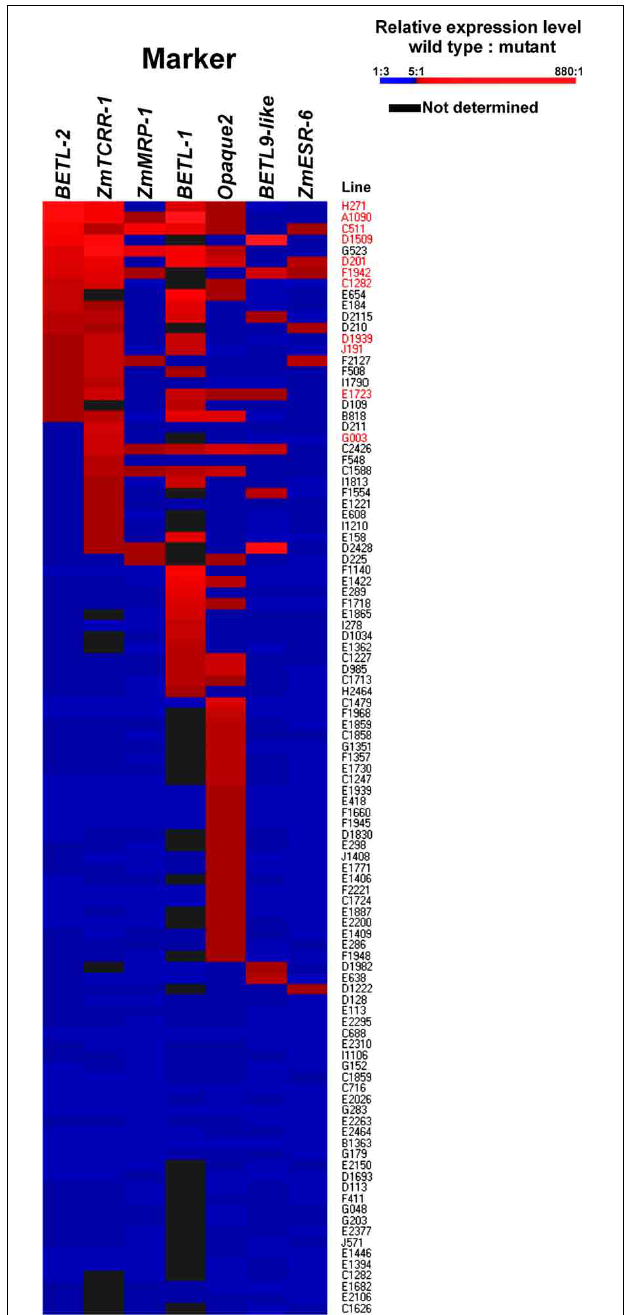
FIGURE 4 | Organization of the 101 lines according to marker expression ratio. Lines are ordered according to the WT/mutant expression ratio, first for BETL-2, then for ZmTCRR-1 . WT/mutant ratios were then converted into color intensities to facilitate graphical representation, according to the scale